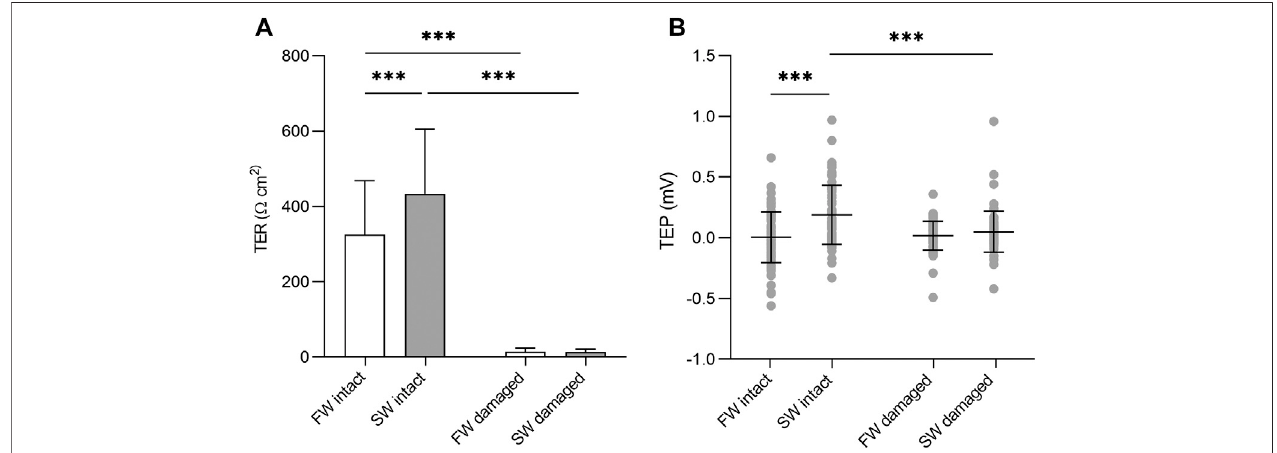
FIGURE 3 | (A) Barchart of transepithelial resistance (TER) and (B) dotplot of transepithelial potential (TEP) in intact skin and skin without the epidermis. Bars represent mean and whiskers represent SD. Signi fi cant differences based on simple effects analysis using one – way ANOVA are denoted with asterisks (*** p <